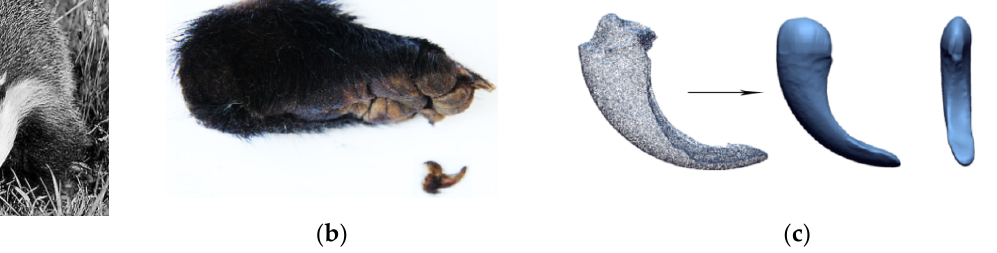
Figure 3. Bionic biological prototype and extraction process. ( a ) Badger burrowing process; ( b ) extraction process of badger claw-toe structure; ( c ) badger claw-toe model.